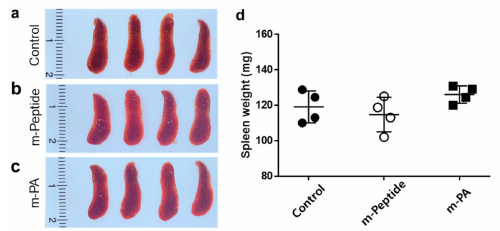
Figure 4. Comparative spleen size and morphology. ( a – c ) Appearance and relative size of the spleens isolated from the mouse groups. ( d ) Relative di ff erences in the spleen weights among the mouse groups. Control, phosphate-bu ff ered saline (PBS) injected; m-peptide, VP1 and VP3 multi-epitope peptide; m-PA, VP1 and VP3 multi-epitope peptide amphiphiles.